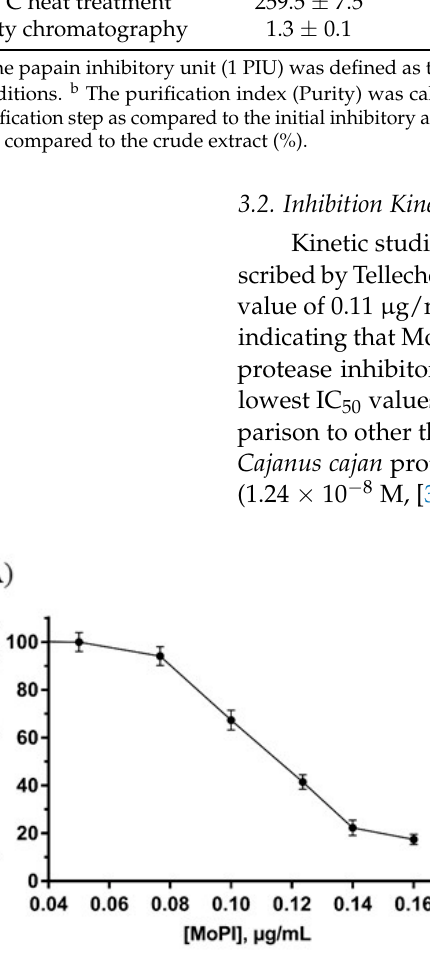
Table 2. Purification steps of MoPI from Moringa oleifera seeds.